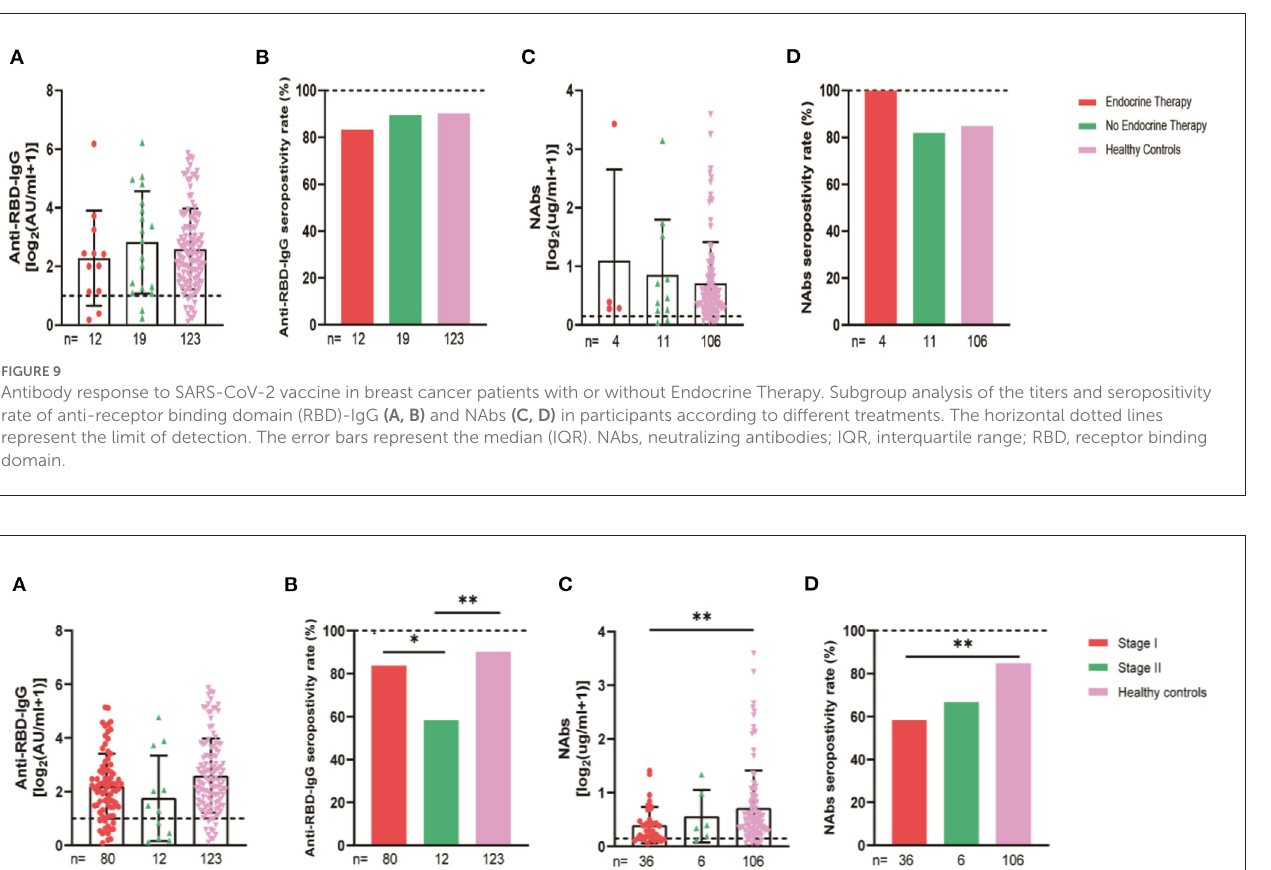
were grouped according to whether Hashimoto’s thyroiditis was combined, and 29.3% (27/92) of the patients in the cancer group had HT and 8.1% (10/123) of the healthy control group had HT, and it was found that the seroconversion rate of the subjects with HT was significantly higher than that of subjects without